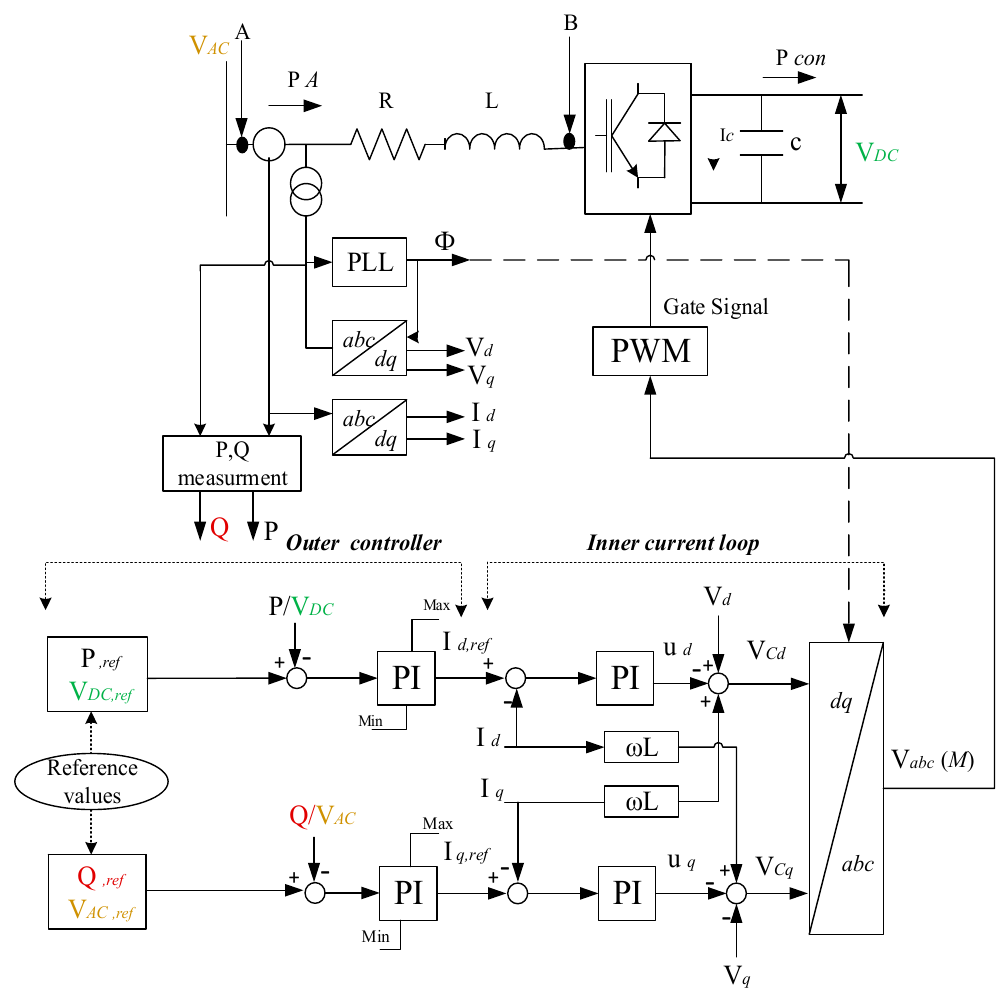
Figure 14. Block diagram of the VSC-HVDC control system.